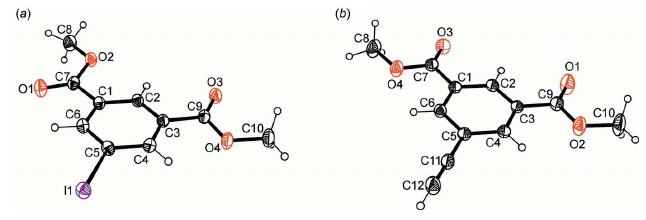
Figure 1 Perspective view of the molecular structures of the title compounds, ( a ) (I) and ( b ) (II), with atom labelling. Anisotropic displacement ellipsoids are drawn at the 40% probability